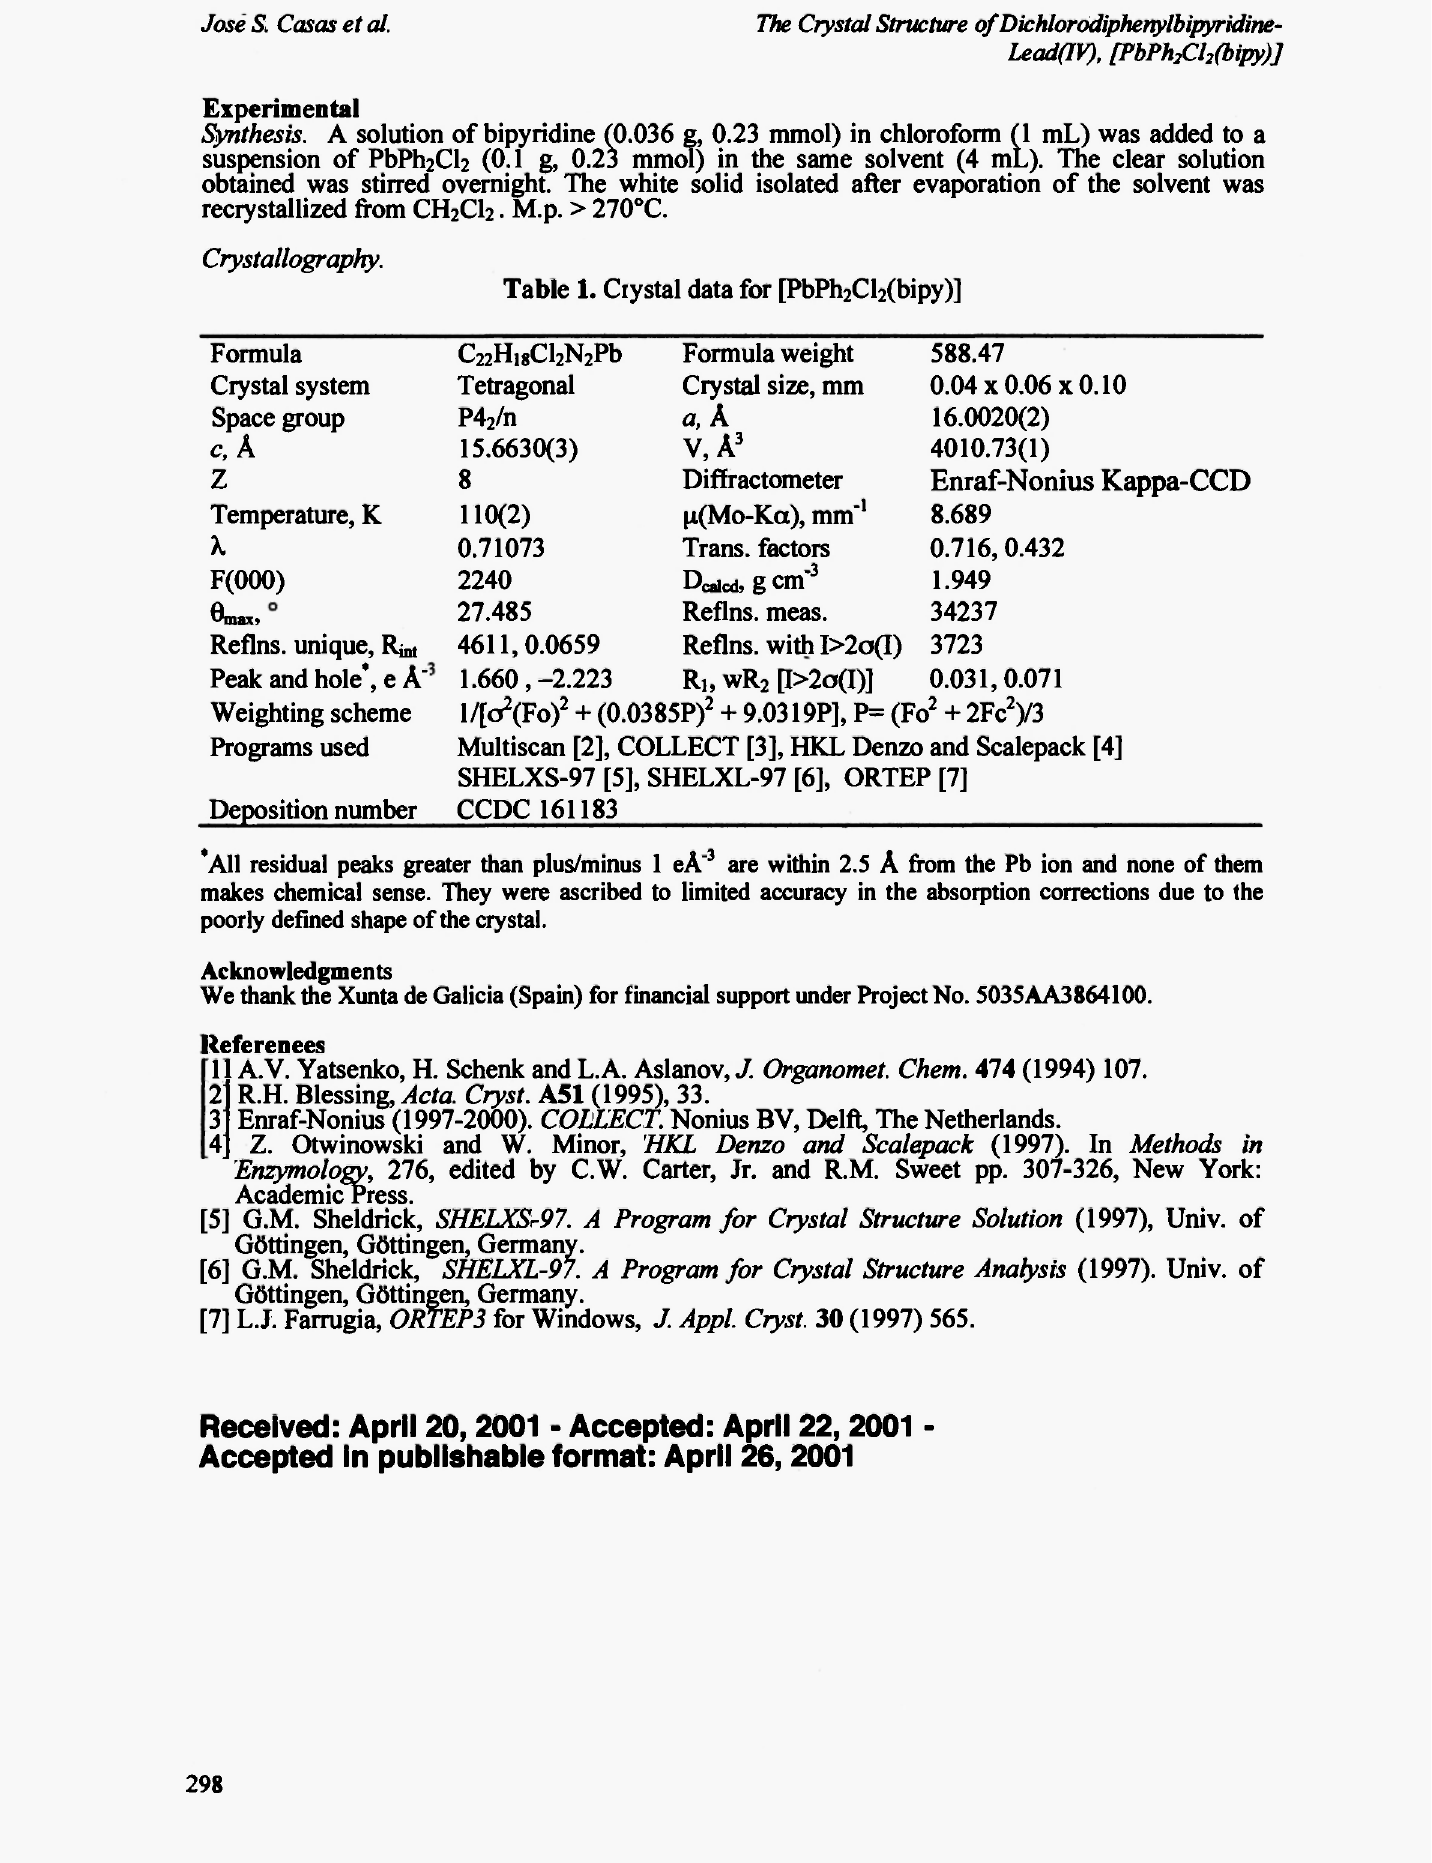
Table 1. Crystal data for [PbPh